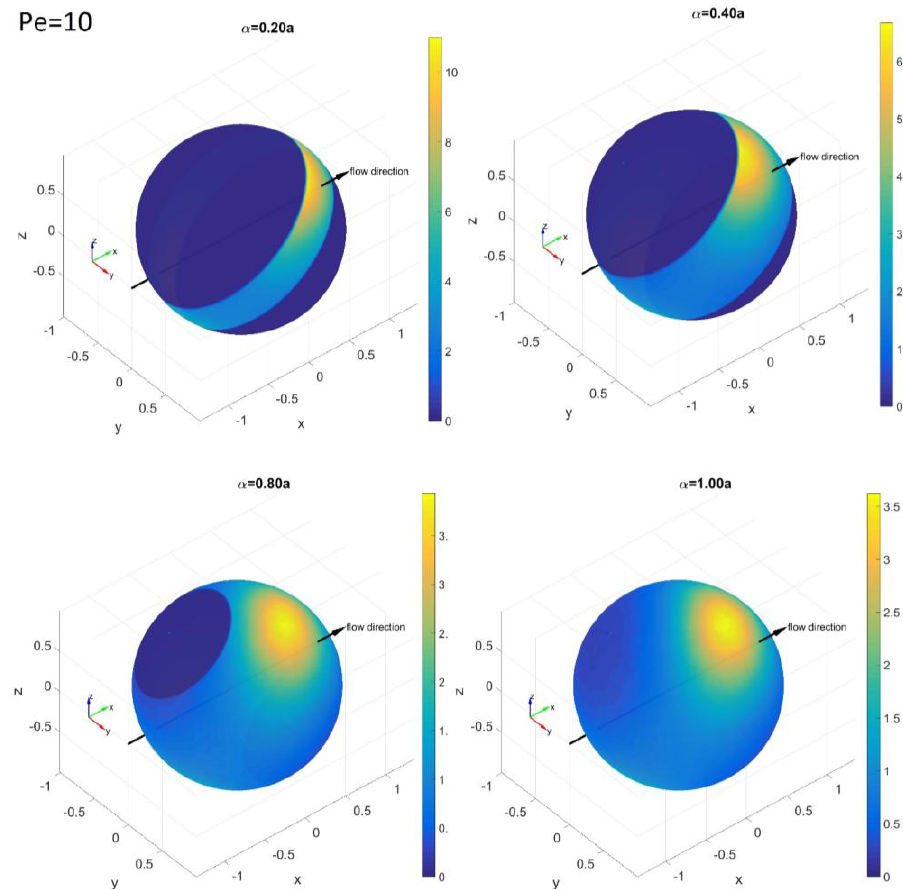
Figure 8. Simulation results for the ( a ) PDF( θ ) and ( b ) PDF( ψ )/sin ψ at Pe = 0.001 with various α / a .